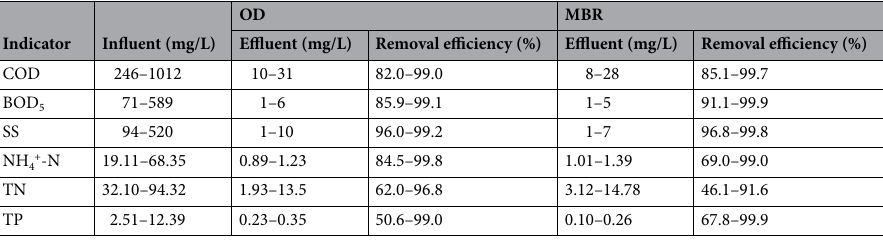
Table 1. Removal of contaminants by the OD and MBR